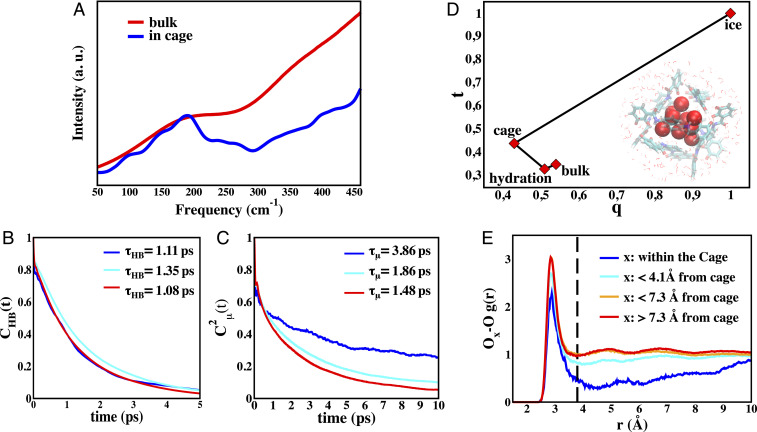
Water HB dynamics inside and outside the Ga4L612− cage. (A) Theoretical THz-IR spectra calculated for water inside the cage (blue) and for bulk liquid water taken from previous work (48) (red). The intensities are rescaled in order to have the same intensity for the maximum at ∼180 cm−1 to aid comparison. (B) Hydrogen-bonded lifetimes CHB(t) and (C) orientation correlation Cμ(2)(t) dynamics inside the cage (blue), in the hydration layer (cyan) and in the bulk liquid (red). The characteristic relaxation times are also reported in the legend (details on defined regions are given in SI Appendix, Text and Fig. S5). (D) The t and q order parameter space showing their values for cubic ice, water confined inside the cage, water in the hydration layer outside the cage (<4.1 Å), and bulk liquid water. The t parameter value for cubic ice (t = 1) is estimated for a fcc crystal (52), while that the q parameter (q = 1) is that of a perfect tetrahedral environment. The Inset illustrates the average position of the nine arrested water molecules with long residence time inside the cage. (E) Oxygen–oxygen radial distribution function gOO(r) for water inside the cage (blue) compared to the bulk (red).